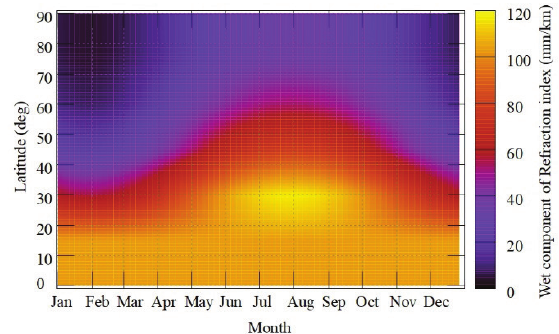
Figure 2. Simulation of the dry component of the troposphere refraction index